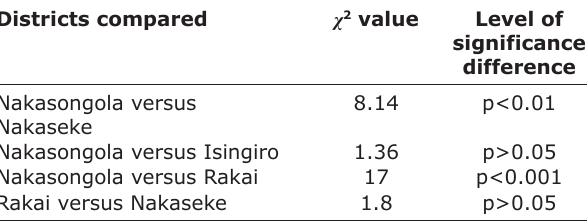
Table-9: Household expenditure on drugs, vaccines, and labor during FMD outbreaks. Districts compared χ 2 value